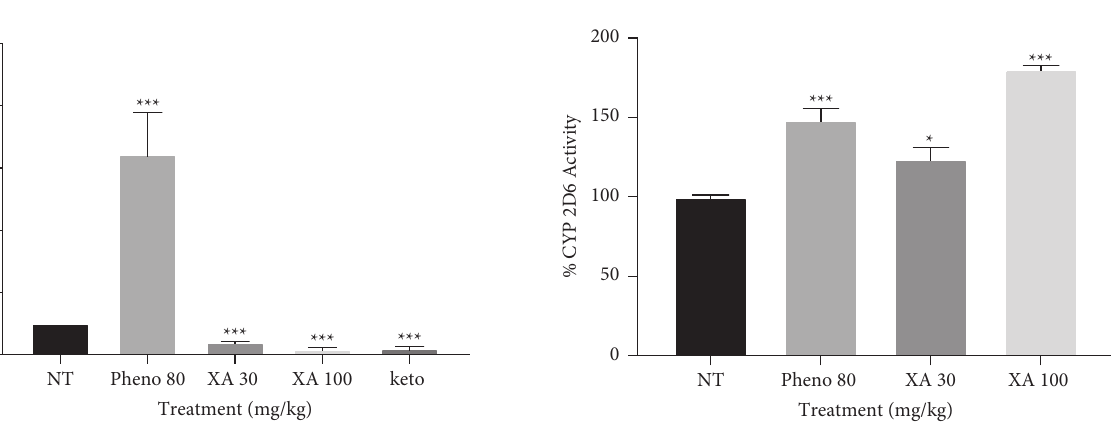
Figure 7: Effect of phenobarbitone (Pheno 80), xylopic acid low dose (30 mg/kg; XA 30), and xylopic acid high dose (100mg/kg; XA 100) on CYP 2D6 (dextromethorphan O-demethylation). Data are presented as mean ± S.E.M. ∗ P < 0 . 05 and ∗∗∗ P < 0 . 001 compared to the no-treatment group (one-way ANOVA followed by Tukey’s post hoc